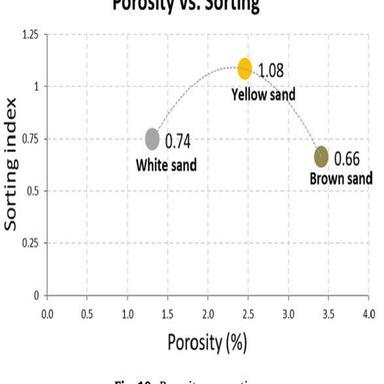
Porosity vs. sorting.